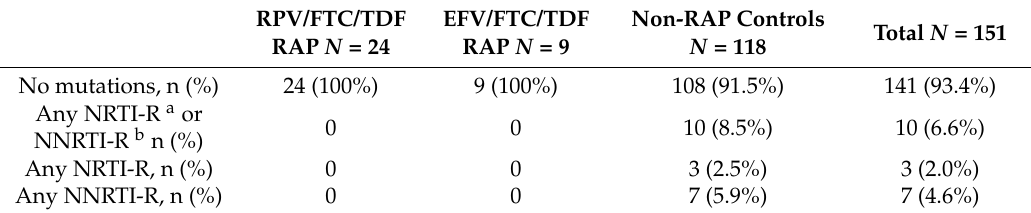
Table 2. Number of subjects with primary NRTI and NNRTI drug resistance mutations detected at low frequency ( ě 2% to 20%) in baseline samples by deep